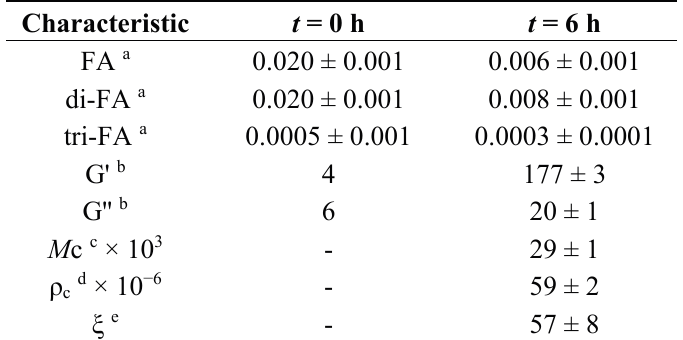
Table 1. Characteristics of WBAX before and after 6 h gelation.